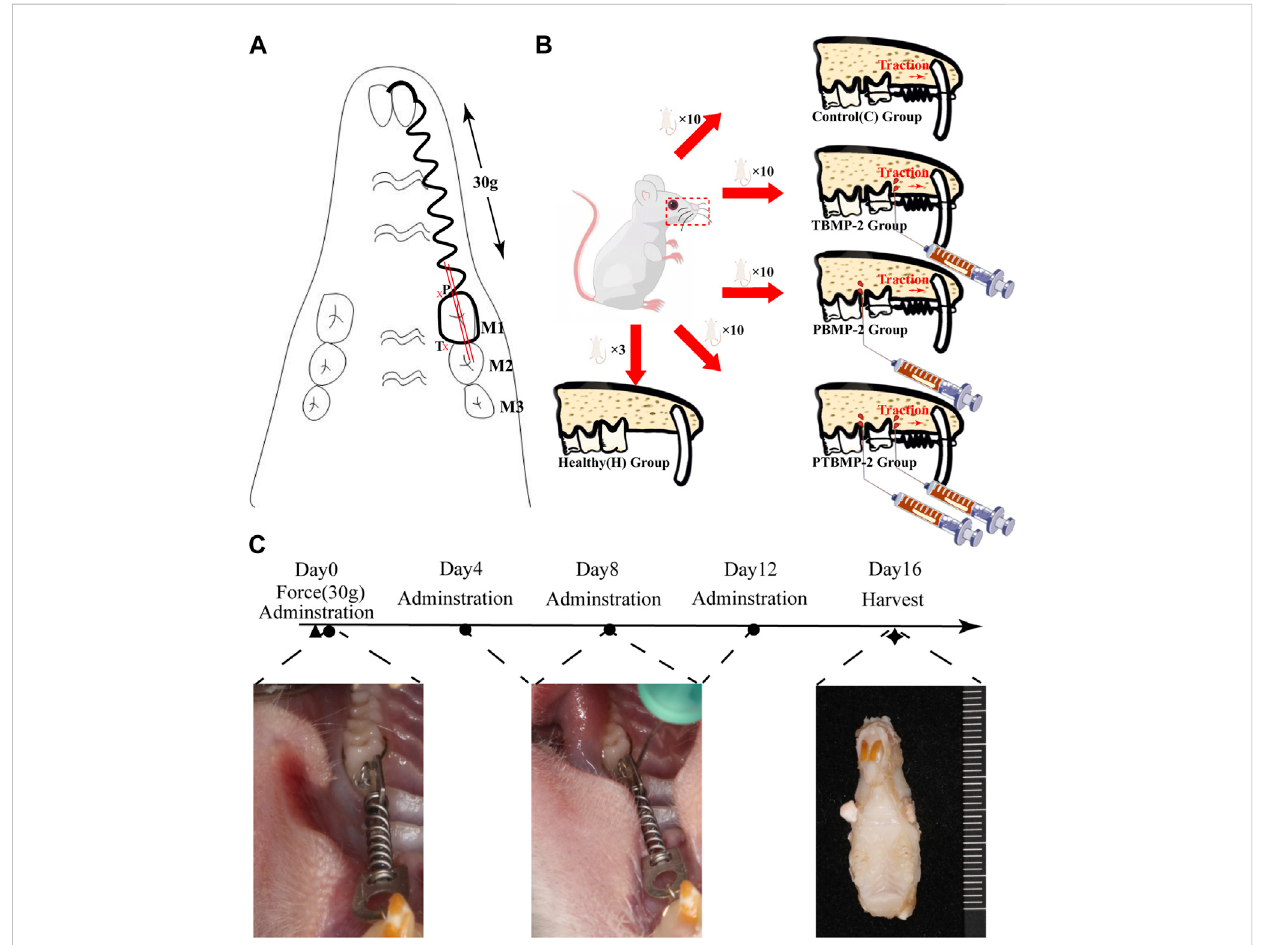
FIGURE 1 Experimentaldesign.Establishmentoforthodontictoothmovement(OTM)model (A) .AclosedcoilNiTispringwasligatedbetweentheleftmaxillary centralincisorandthe fi rstmolar(M1).Aconstantforceof30 gwasensured.Theadministration sitewasde fi nedonthepressureside(P)andtensionside (T) side of the orthodontic tooth 0.5 mm close to the periodontal ligament. The whole morphology of the mesial root of M1 was captured in sections taken from the mesial and distal sides (double red bar) along the long axis of M1. Group distribution (B) . 40 healthy SD rats were randomly allocated into four groups based on different interventions on the established OTM model: 1-blank control (C) group without intervention on the orthodontic tooth;2-PressureBMP-2(PBMP-2)groupwithadministrationofBMP-2onthepressuresideoftheorthodontictooth;3-TensionBMP-2(TBMP-2)group